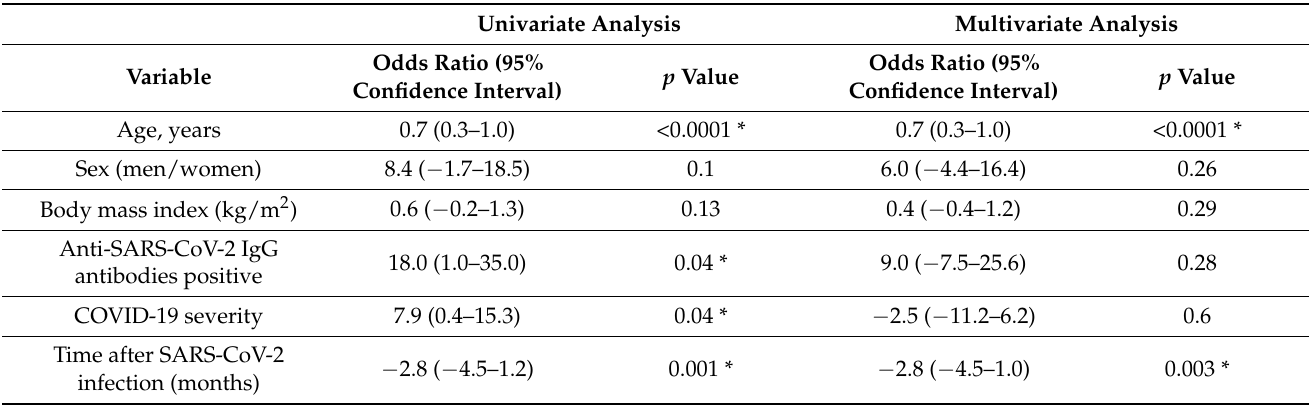
Table 5. Univariate analysis and multivariate analysis of factors associated with Membrane (M) protein SARS-CoV-2 specific T cell response in ELISpot analysis. *